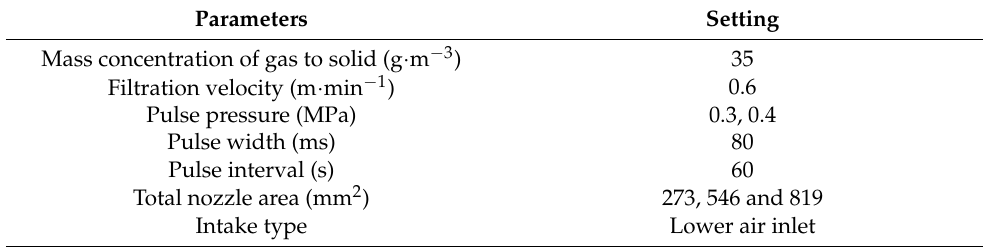
Table 6. Experimental design parameters of the industrial dust test system. Parameters